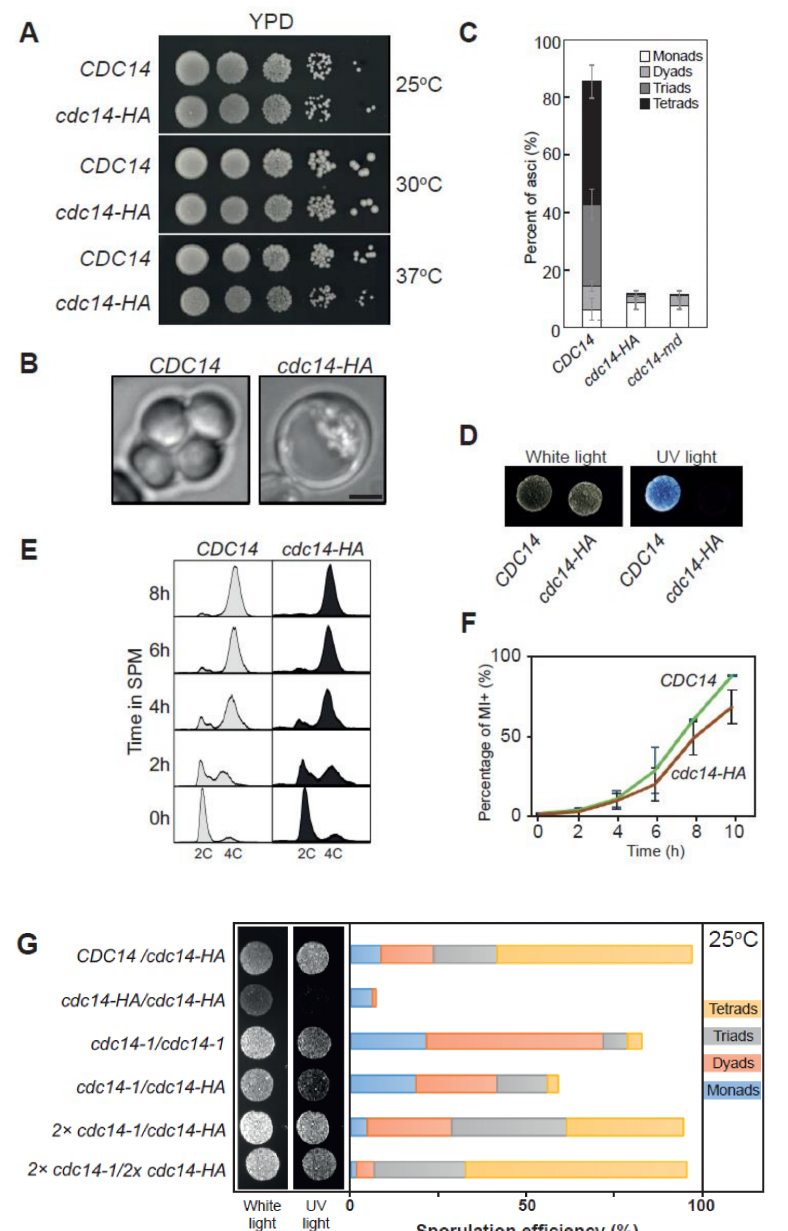
Figure 1. cdc14-HA behaves as a specific sporulation-deficient separation-of-function allele of CDC14 . ( A ) The cdc14- HA allele does not perturb normal growth conditions when cultivated at 25 ◦ C, 30 ◦ C and 37 ◦ C in rich media (YPD). ( B ) Homozygous cdc14-HA diploids do not form asci containing spores under standard conditions for sporulation. Scale bar represents 1 µ m. ( C ) Percentage of sporulation in CDC14 (JCY840), cdc14-HA (JCY844) or cdc14-md (JCY2376). Error bars represent the standard deviation of the mean (SEM) calculated from at least three independent experiments. A minimun of 300 cells per strain were counted. ( D ) cdc14-HA diploid cells divide mitotically but lack di-tyrosine autofluorescence induced by UV light after several days of incubation in SPM media at 30 ◦ C. ( E ) FACS analysis of DNA content shows that cdc14-HA cells complete meiotic DNA replication with identical kinetics as CDC14 diploid cells. ( F ) cdc14-HA cells undergo meiotic nuclear divisions at subtly slower kinetics, and reduced frequencies, than CDC14 cells. Error bars represent the SEM over the mean values plotted. ( G ) Di-tyrosine autofluorescence of different mutant combinations as well as the control strains grown and sporulated on plates at 25 ◦ C. cdc14-1 homozygous diploids (JCY2353) sporulate at high efficiency under semi-permissive temperature forming preferentially tetrads whereas cdc14-HA homozygous diploids (JCY844) do not sporulate. Combinations, and variable copy number, of the mutant genes can rescue the sporulation defect to different degrees